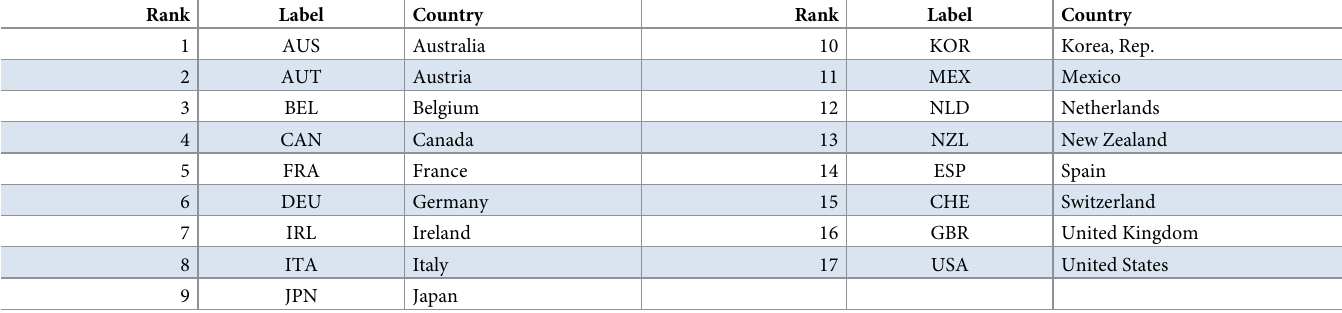
Table 1. Countries included in the strongest connected component GTN s of the global inbound tourism network � . Rank